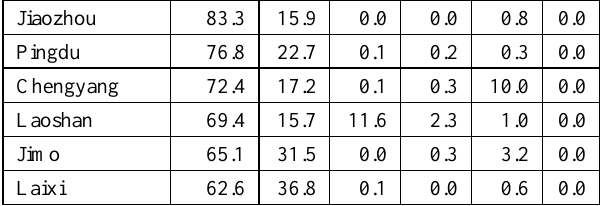
Table 4 . The area proportions of different land cover types of